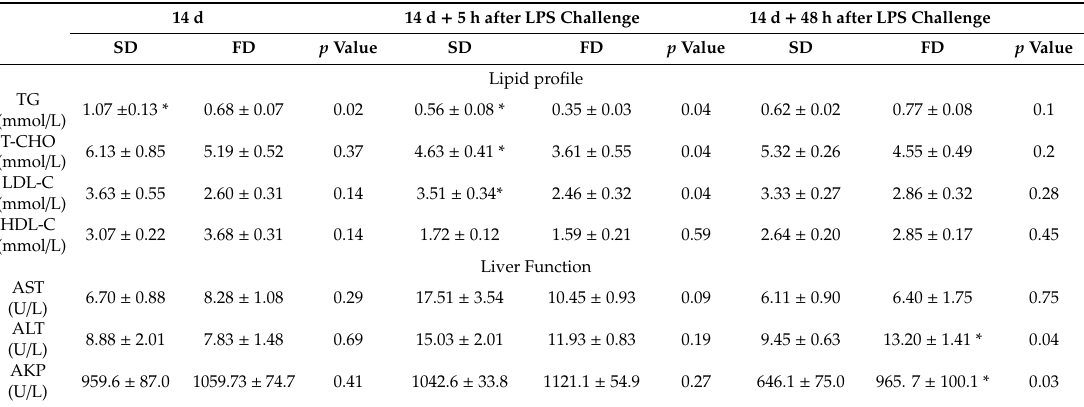
Table 5. E ff ect of the maternal diet with fish oil on the lipid profile and liver function in the plasma of piglets pre- and post-LPS challenge. 14 d 14 d + 5 h after LPS Challenge 14 d + 48 h after LPS Challenge SD FD p Value SD FD p Value Lipid profile TG 1.07 ± 0.13 (mmol / L)